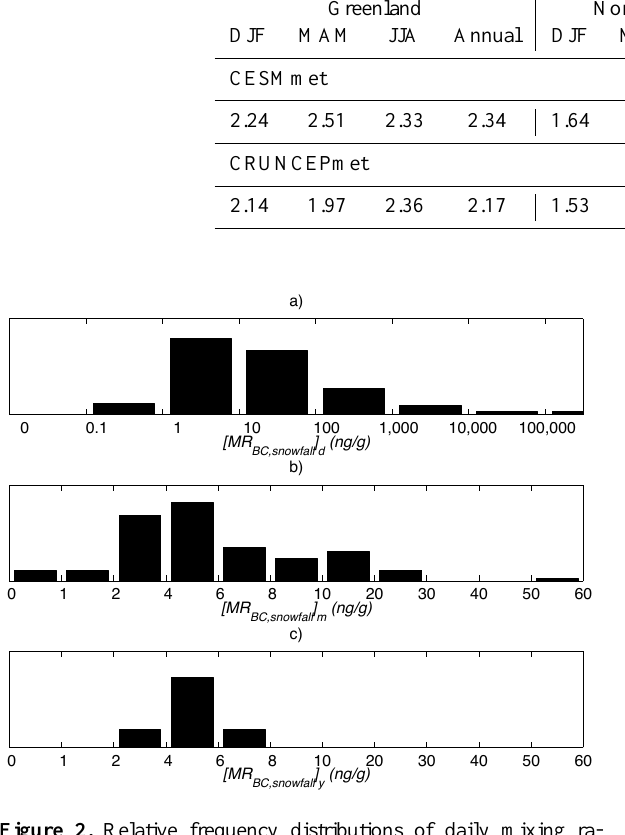
Figure 2. Relative frequency distributions of daily mixing ra- tios of BC in snowfall calculated using three different pairings of BC mass deposition fluxes and snowfall rates, as described in the text: (a) [MR BC,snowfall ] d , (b) [MR BC,snowfall ] m and (c) [MR BC,snowfall ] y . Note the differences in scale in (a) versus in (b) and (c) . Data shown are for model snowfall rates for year 2000 (CESMmet runs) and for the dye-2 Greenland grid box as shown in Fig. 1a.